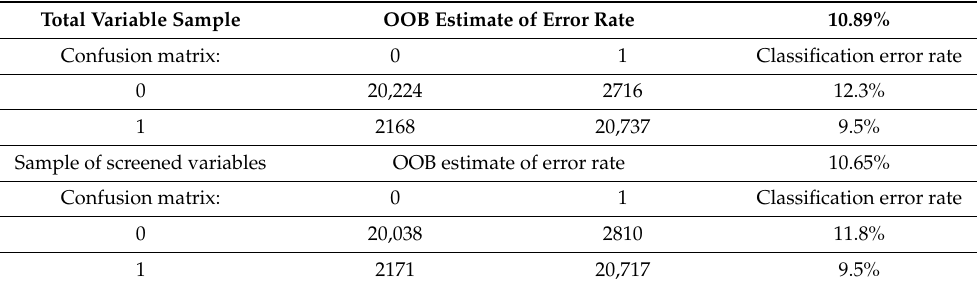
Table 5. The results of the OOB and confusion matrix of the two